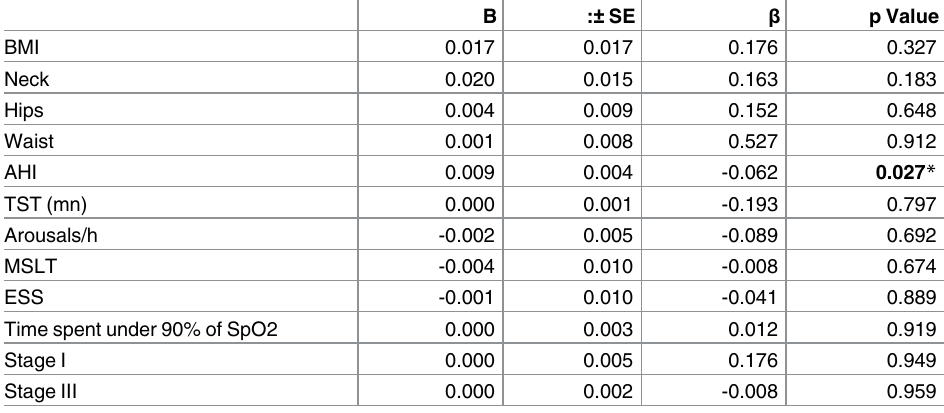
Table 3. Summary of multiple linear regression for screening variables predicting on HOMA-IR in total